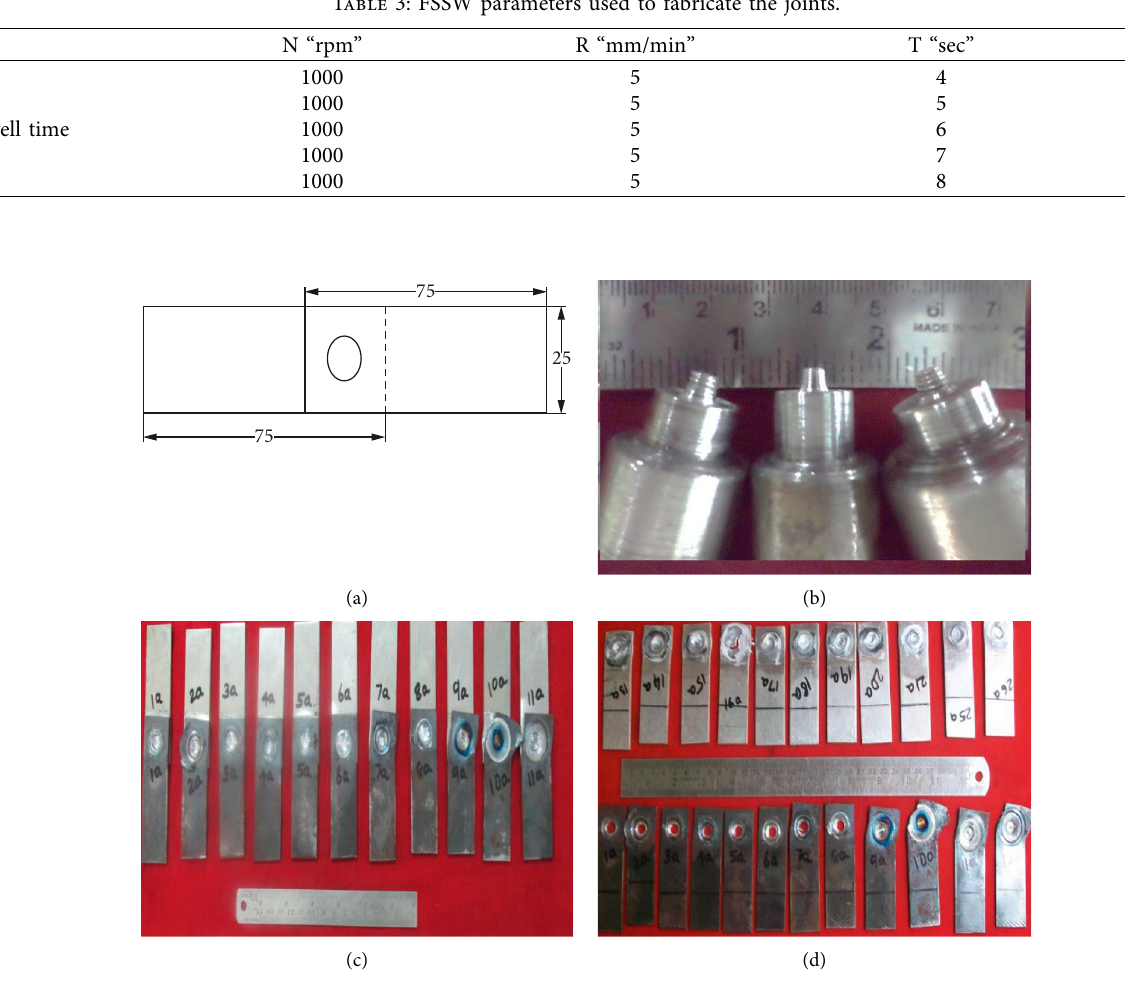
Figure 1: (a) Schematic diagram of FSSW joint, (b) fabricated FSSW tools, (c) fabricated joints (before testing), and (d) fabricated joints (after testing).